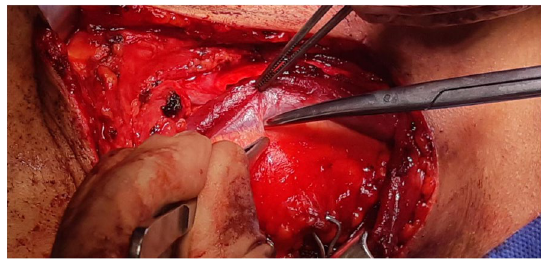
Fig. 3 Dissection of the internal jugular vein (IJV), common carotid artery (CCA), and vagus nerve from the anterior surface of the